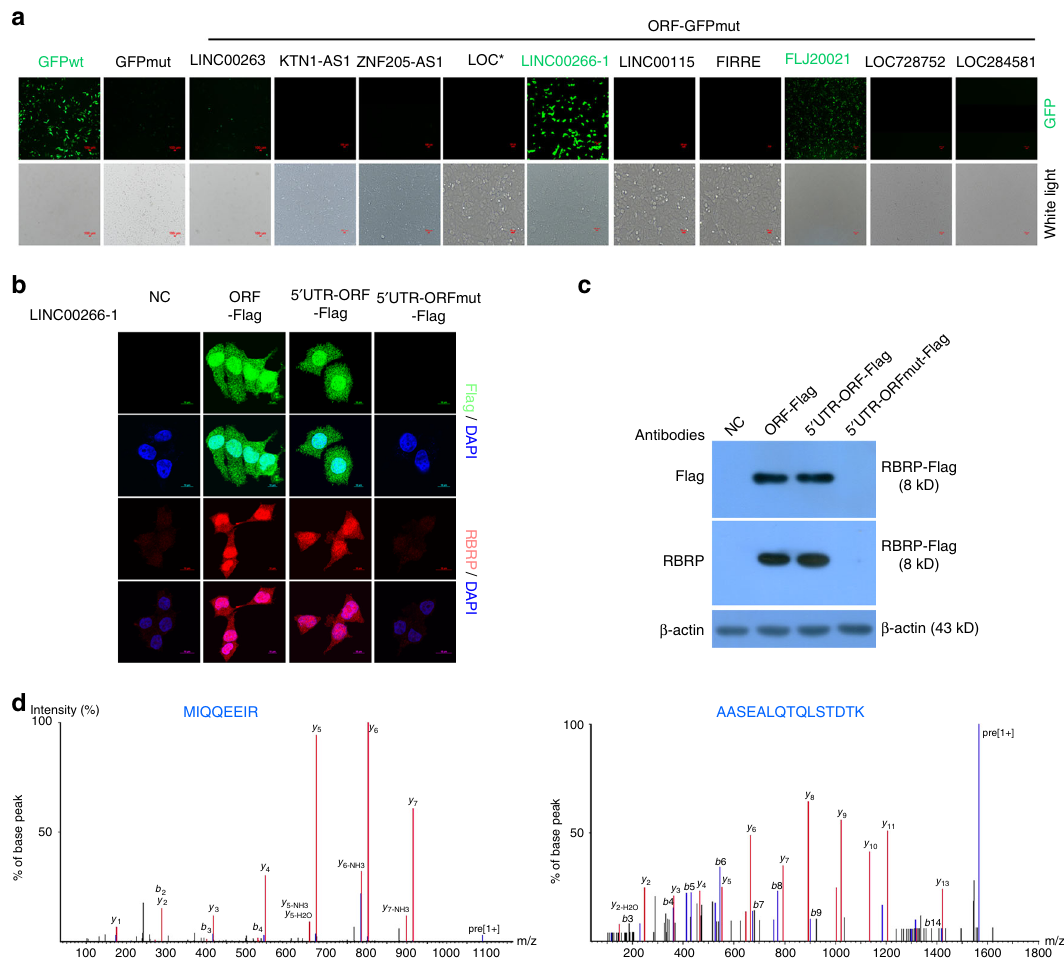
Fig. 1 The lncRNA LINC00266-1 encodes a 71-aa peptide, RBRP. a The ORF-GFPmut constructs of ten indicated lncRNAs were transfected into HeLa cells and GFP fl uorescence was detected. LOC* is LOC100126784 and FIRRE is also named LOC286467 . Scale bar: 100 μ m. b , c The indicated constructs were transfected into HeLa cells for 48 h, immunostaining of the RBRP-Flag fusion peptide was detected with anti-Flag and anti-RBRP antibodies ( b ), and levels of the RBRP-Flag fusion peptide were detected by performing western blottings with anti-Flag and anti-RBRP antibodies ( c ). Scale bar: 10 μ m. d Two unique peptides in the RBRP peptide were identi fi ed using mass spectrometry. Source data are provided as a Source Data fi